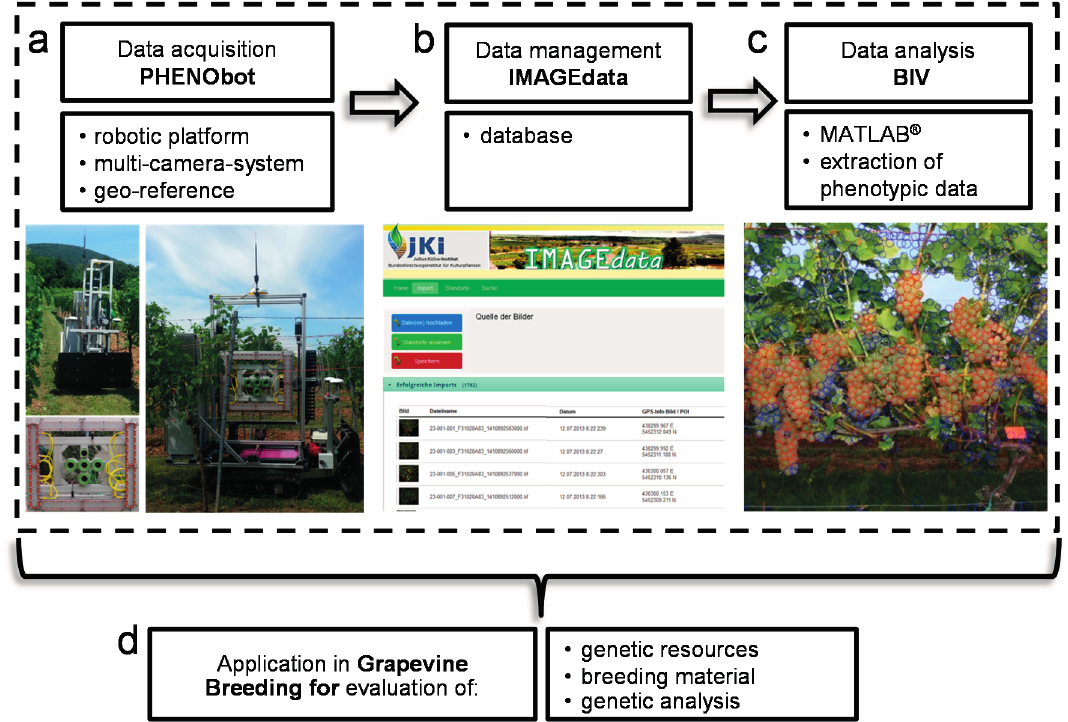
Figure 3. Phenotyping pipeline in grapevine breeding. ( a ) Data acquisition using the PHENObot consisting of a robotic platform, a multi-camera-system and a geo-information system; ( b ) data management of the sensor data is achieved by a database ( IMAGEdata ); ( c ) data analysis through the application of MATLAB ® -based tools, e.g., BIVcolor (Berry in Vineyards-color), to extract the phenotypic data; ( d ) the phenotyping pipeline was